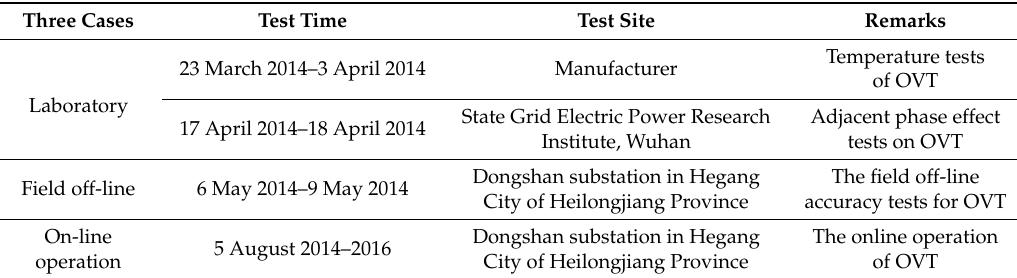
Table 1. Testing cases list for Table 1 . Testing cases list for OVTs. Table 1 . Testing cases list for OVTs.